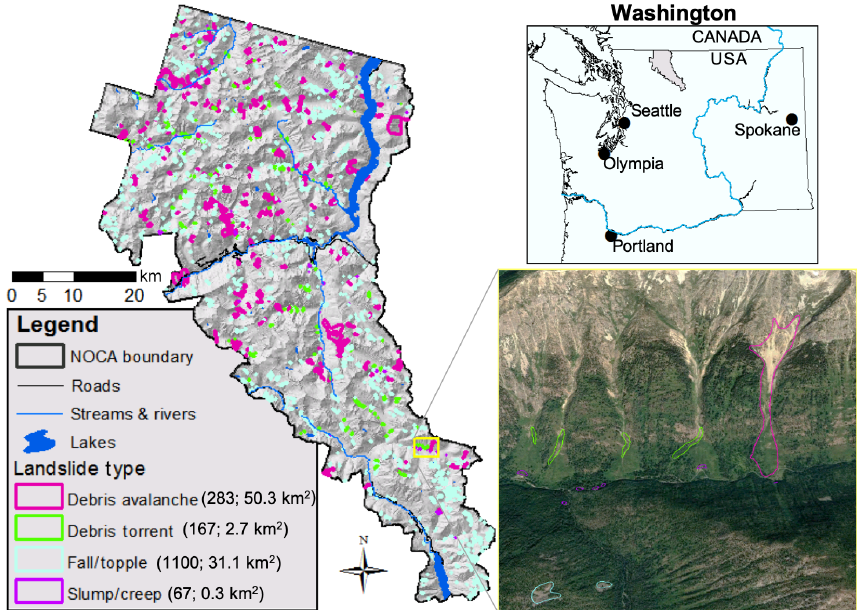
Figure 3. Four landslide types mapped within the North Cascades National Park Complex (NOCA) in Washington, USA. The number and their total area of each type is given in parentheses. Insert provides an example of mapping over an aerial image (© Google Earth) taken at 48 ◦ 27 (cid:48) 20.21 (cid:48)(cid:48) N, 120 ◦ 44 (cid:48) 47.09 (cid:48)(cid:48) W with imagery data from 27 August